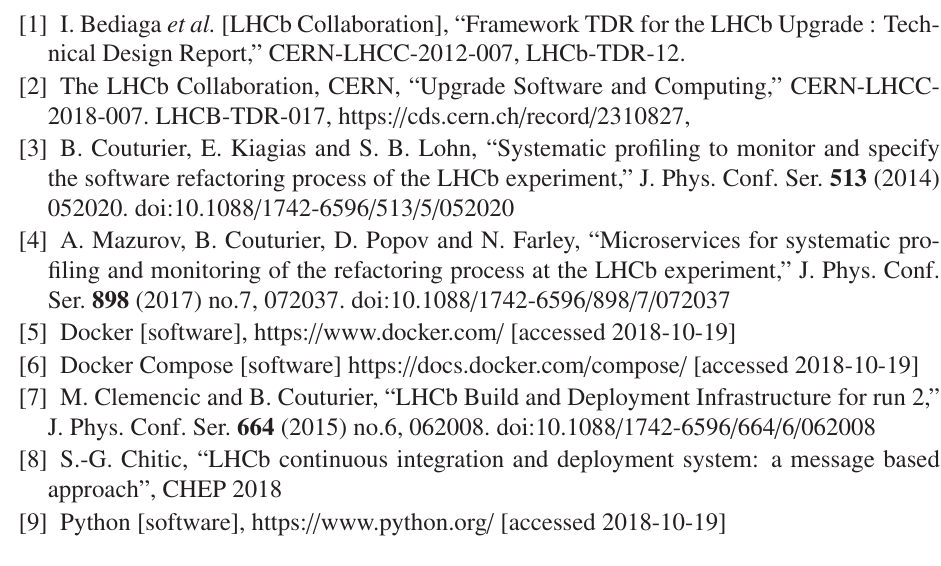
Figure 3. CPU time spent by the simulation application as function of the software